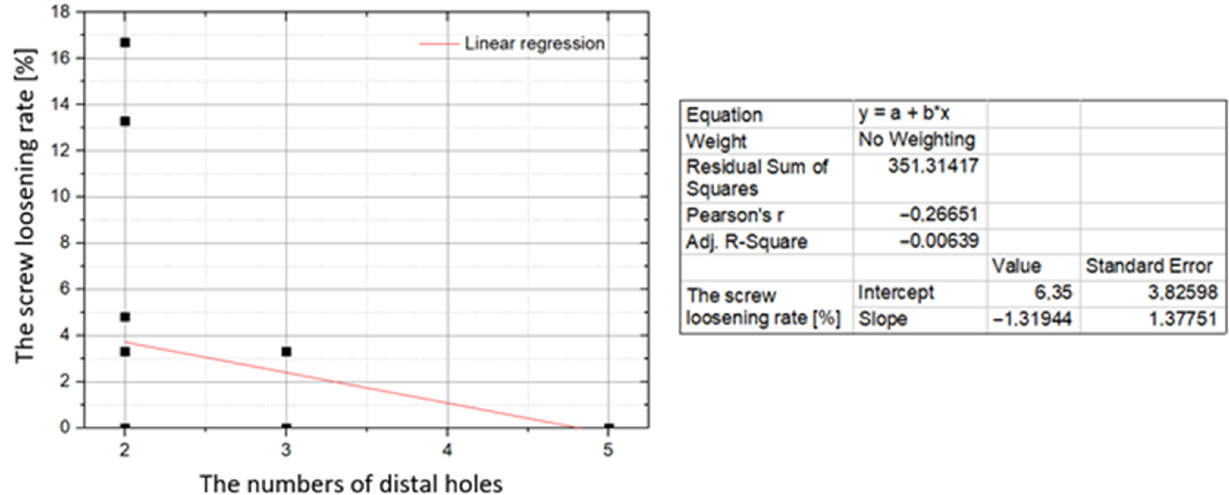
Figure 3. Correlation between the screw loosening rate (vertical axis) and the distal number of holes in the 3D mini-plate (horizontal axis). Data for individual studies.